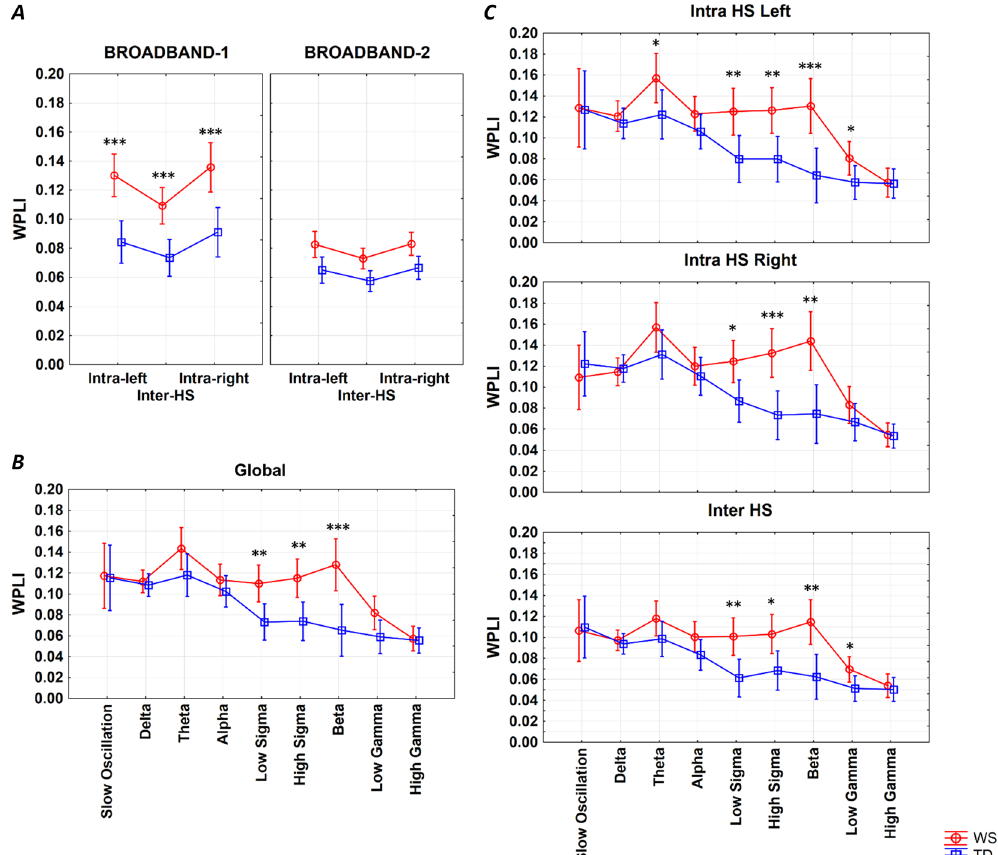
Figure 4. REM sleep EEG WPLI means. ( A ) Intra- and interhemispheric REM sleep EEG broadband-1 and broadband-2 WPLI means of Williams syndrome and typically developing subjects (means and 95% confidence intervals). Intra-left – left intrahemispheric, Inter-HS – interhemispheric, Intra-right – right intrahemispheric. * p < 0.05, ** p < 0.01, *** p < 0.001, according to post-hoc Fisher LSD tests following a 3-way ANOVA with repeated measures(Group × Intrahemispheric/Interhemispheric × Band). ( B ) Band-limited global WPLI means of Williams syndrome and typically developing subjects’ REM sleep EEG recordings (means and 95% confidence intervals). * p < 0.05, ** p < 0.01, *** p < 0.001, according to post-hoc Fisher LSD tests following a 2-way ANOVA with repeated measures (Group × Band). ( C ) Band-limited intra- and interhemispheric WPLI means of Williams syndrome and typically developing subjects’ REM sleep EEG recordings (means and 95% confidence intervals). * p < 0.05, ** p < 0.01, *** p < 0.001, according to one-way